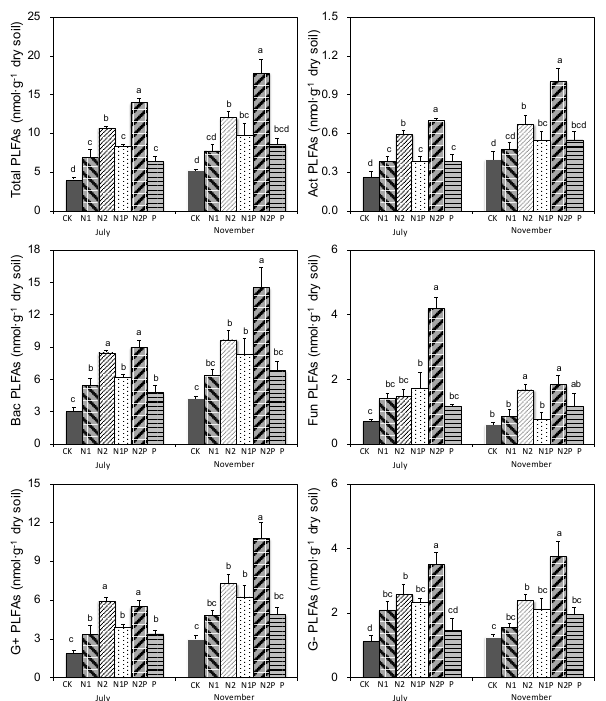
Figure 3. Responses of soil microbial PLFAs to N and P additions in Chinese fir plantations in July and November (different lower- case letters in different bars indicate significant differences when P <0.05. totPLFAs: total PLFAs; bacPLFAs: bacterial PLFAs; act- PLFAs: actinomycete PLFAs; G + PLFAs: Gram-positive bacterial PLFAs; G − PLFAs: Gram-negative bacterial